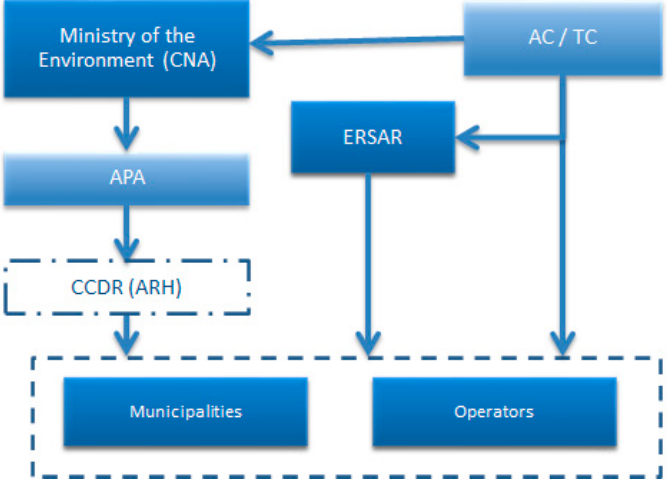
Figure 1. Institutional framework of the water sector in Portugal.